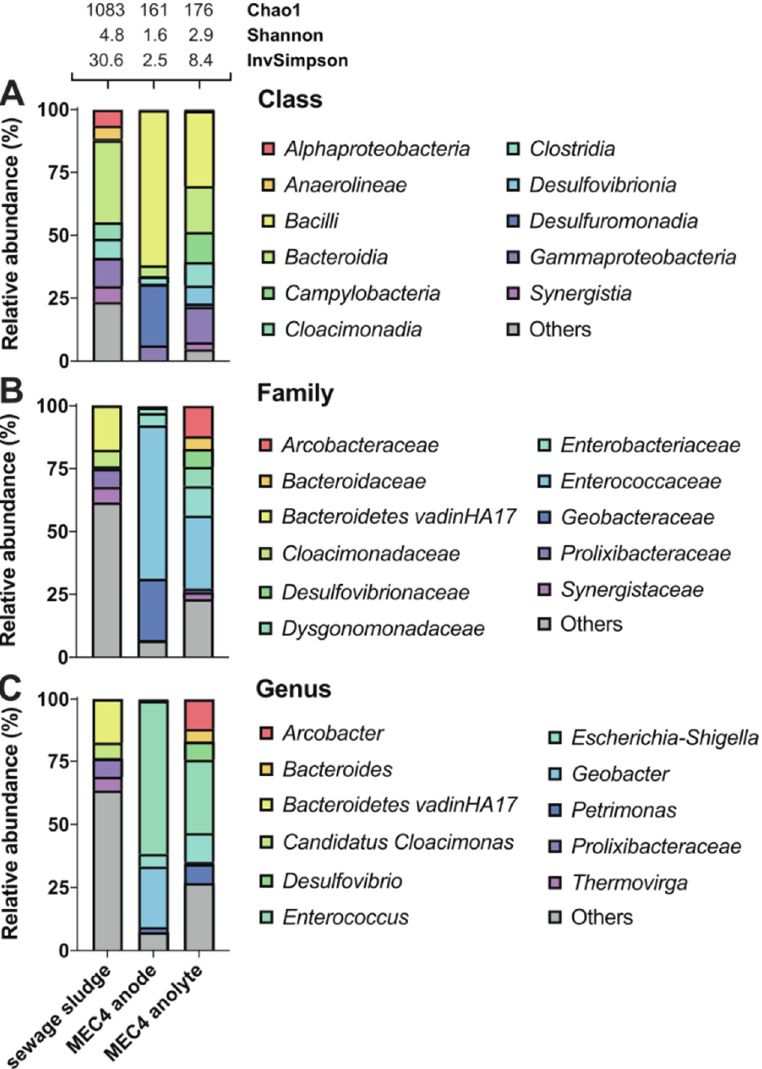
Figure 4. Effect of sewage sludge enrichment on the microbial community composition in MEC4. Sewage sludge represents the primary source for enrichment of electrochemically active microorganisms. MEC4 anode represents the microbial biofilm on the surface of the carbon felt electrode. MEC4 anolyte represents planktonic microorganisms in the anode chamber. Taxonomic profiles were set at class ( A ), family ( B ), and genus ( C ) levels. Only representatives with a relative abundance >5% in at least one condition are shown. Detailed data are shown in Supplementary Table S4. Alpha diversity was estimated using the following indices: Chao1, Shannon, and Inverse Simpson.